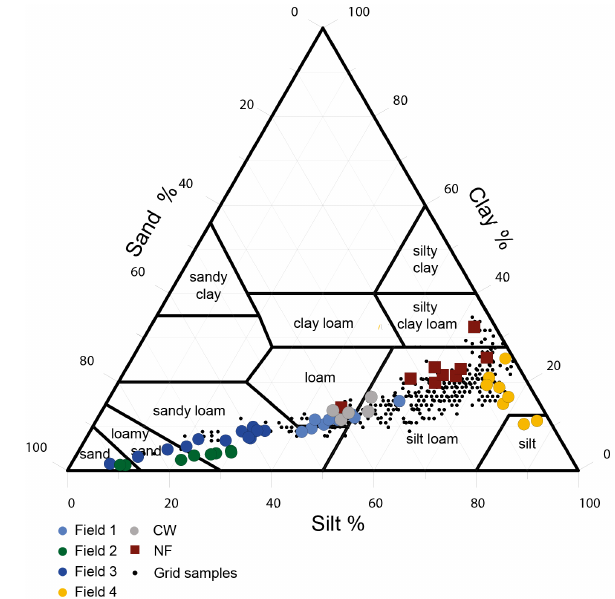
Figure 3. Soil texture triangle including all measured samples.